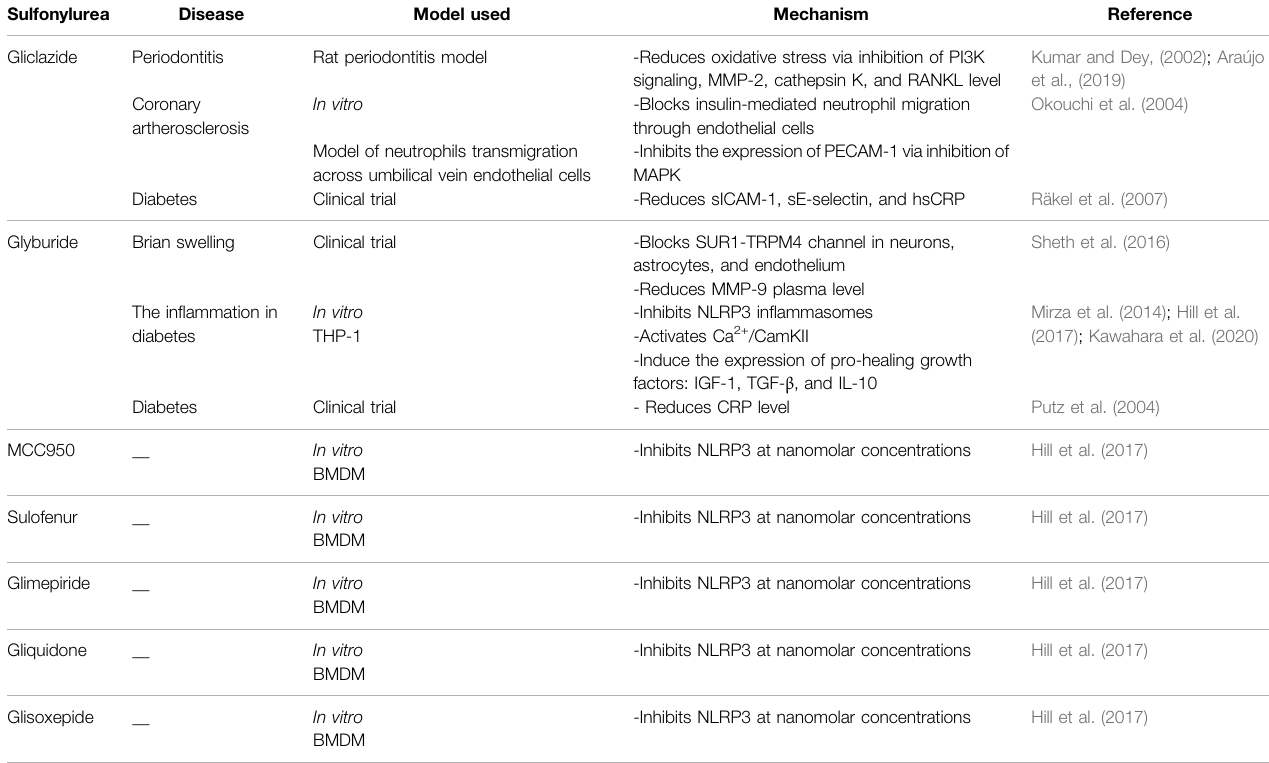
TABLE 1 | Effect of sulfonylureas in pathophysiology of in fl ammatory diseases.